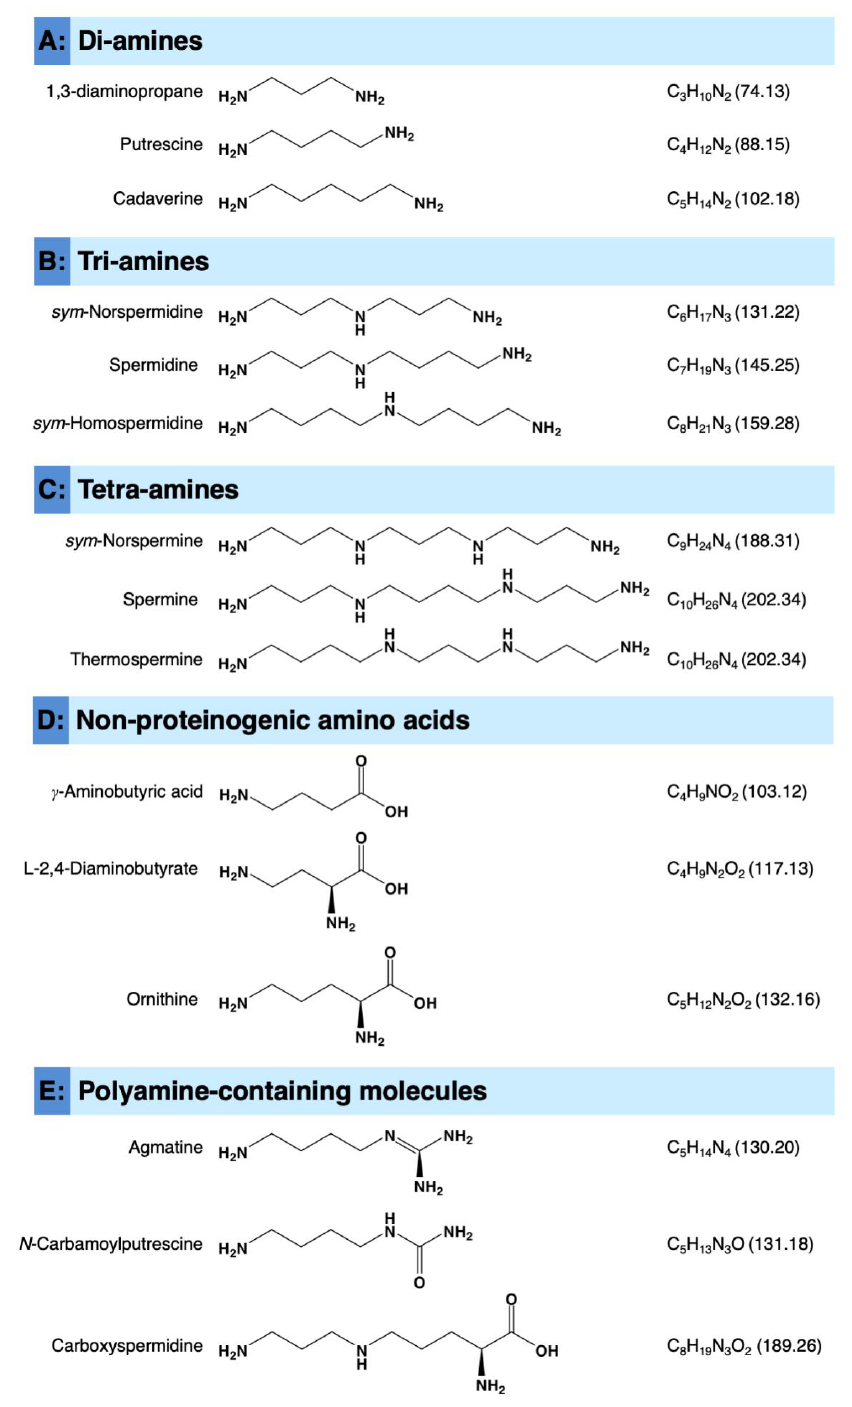
Figure 1. Chemical structures of the polyamines (PAs) and other nitrogen-containing molecules discussed throughout this review. ( A ) Diamines, ( B ) Tri-amines, ( C ) Tetra-amines, ( D ) Non-proteinogenic amino acids, and ( E ) Polyamine-containing molecules. Molecular weight/molar mass (g.mol −1 ) is mentioned between parentheses beside the chemical formula of each compound.